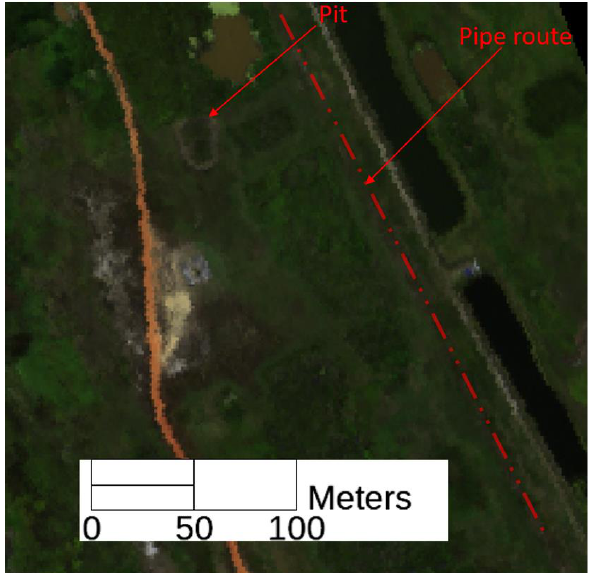
Figure 4: Respective locations of mudpit and